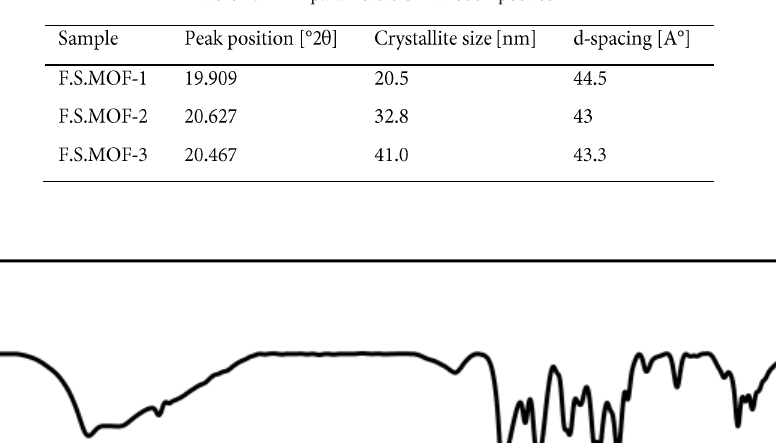
Fig (5): FTIR analysis of magnetic metal-organic nanocomposites with different weight percentages of nickel ferrite.